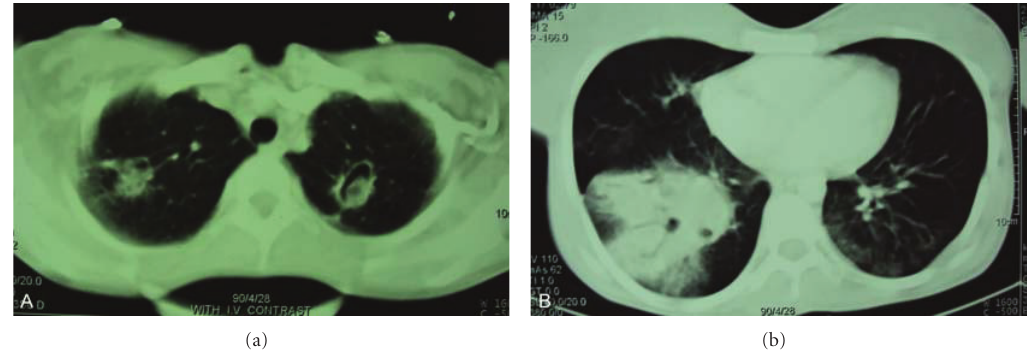
Figure 1: Spiral lung CT scan; (a) biapical cavitary lesions and intracavitary soft tissue projection in the left lung; (b) scattered nodular infiltration with a large mass-like consolidation was seen in the right lower lobe.